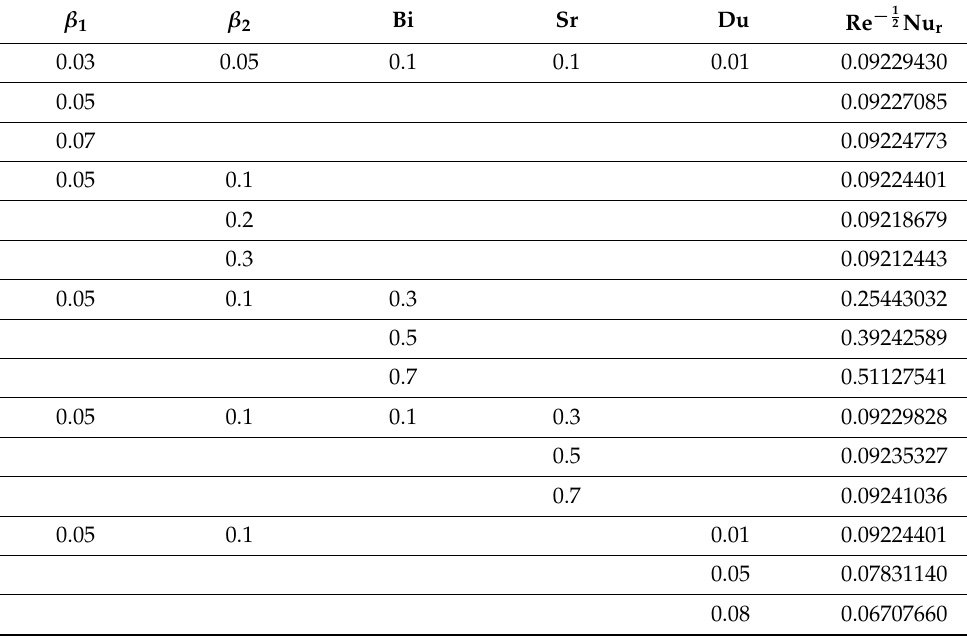
Table 1. Variation of Re − 1 2 Nu r on β 1 , β 2 , Bi, Sr, and Du, respectively.